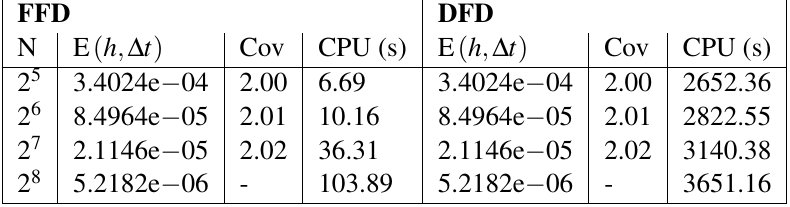
Table 3 L 2 error of numerical solutions obtained by DFD and FFD when ∆ t = 2 − 16 and α = 0 . 7 are fixed